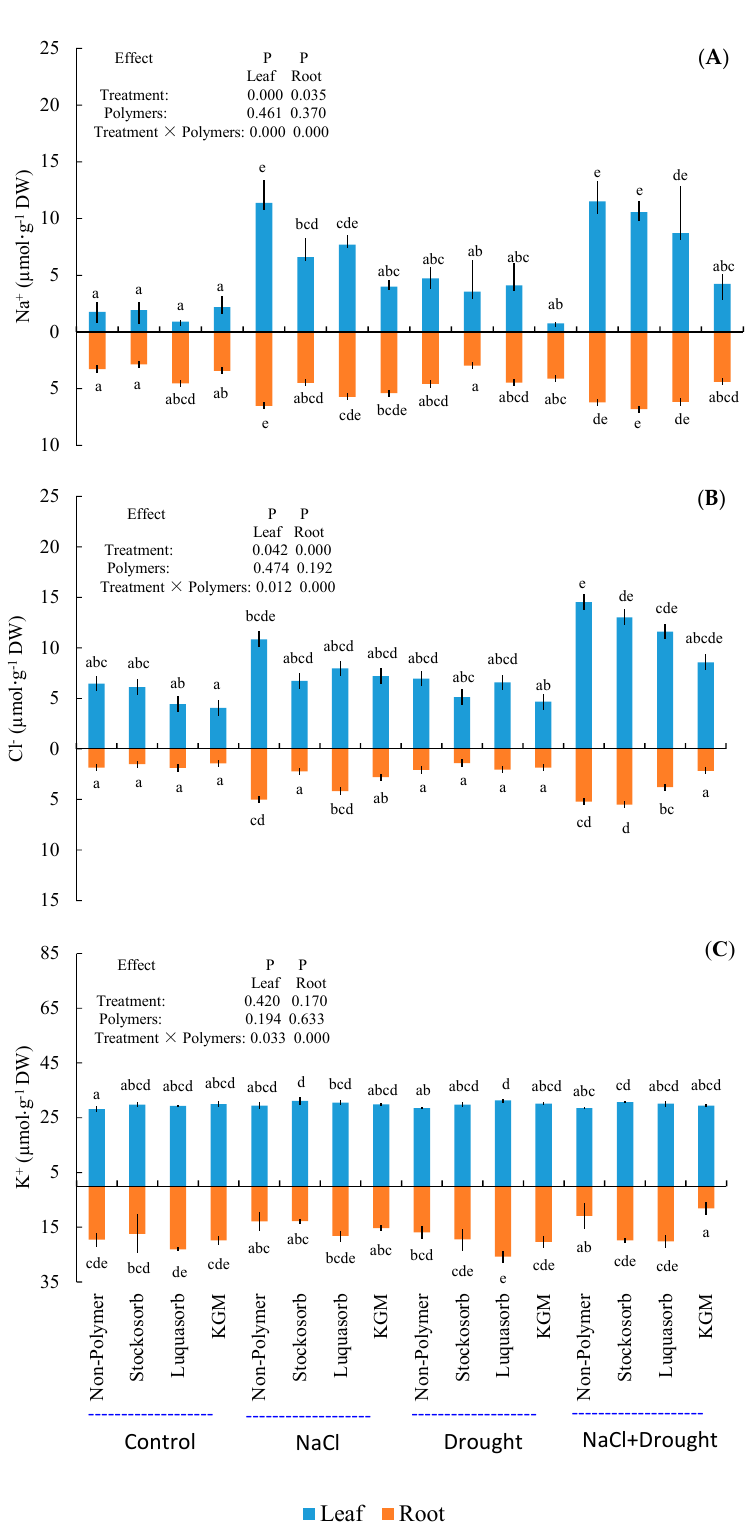
Figure 7. Effects of drought and salt stress on Na + , Cl − , and K + concentrations in the roots and leaves of Metasequoia glyptostroboides seedlings amended with synthetic (Stockosorb, Luquasorb) and natural (Konjac glucomannan, KGM) hydrophilic polymers along with those not amended with polymers (Non-Polymer). ( A ): Na + concentrations. ( B ): Cl - concentrations. ( C ): K + concentrations. Each column represents the mean of three to five individual plants and bars represent the standard error of the mean. Columns labelled with different letters (a–e) are significantly different at the p < 0.05